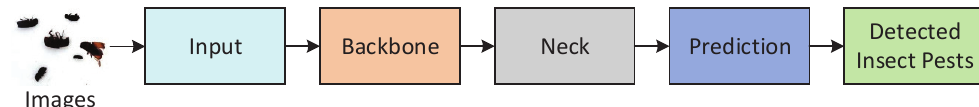
Figure 7. Yolov5 Darknet53